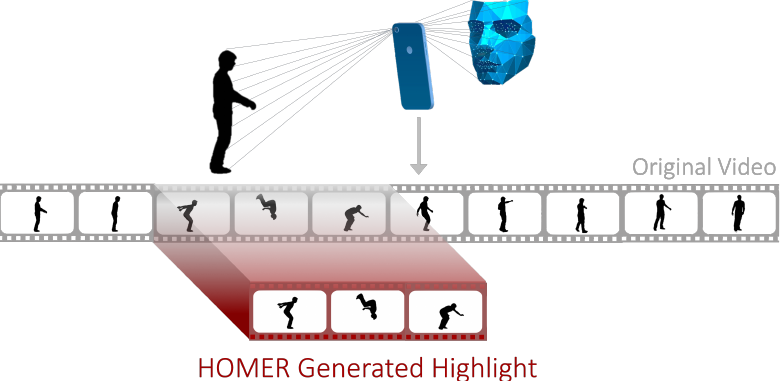
Figure 1. HOMER: a multi-modal video highlight generator based on emotion